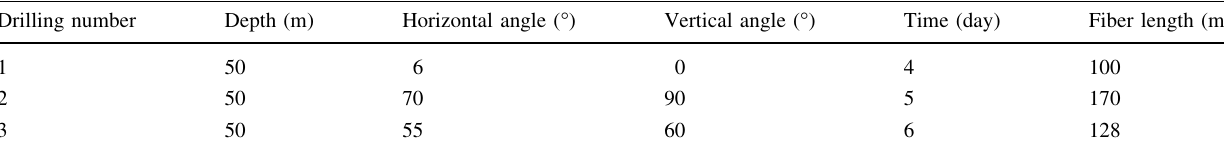
Table 1 Measurement parameters of the drilling